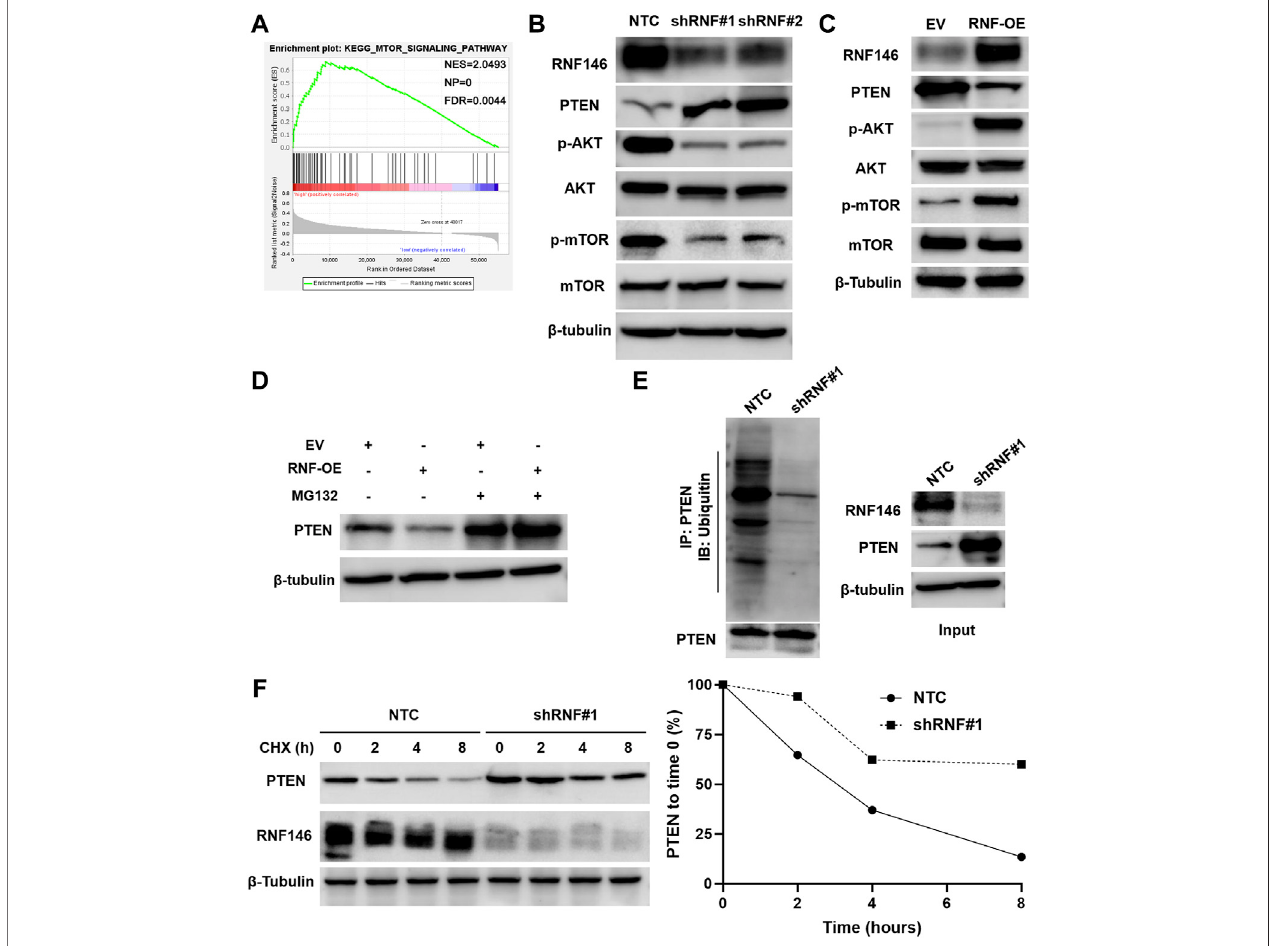
FIGURE6| RNF146regulatesthePTEN/AKT/mTORpathwayinHCCcells. (A) KEGGpathwayenrichmentanalysisindicatedaclosecorrelationbetweenRNF146 and the mTOR signaling pathway in HCC. (B) RNF146 knockdown increased PTEN expression but reduced p-AKT (Ser473) and p-mTOR (Ser2448) levels in HCCLM3 cells. (C) RNF146 overexpression decreased PTEN expression while increased p-AKT (Ser473) and p-mTOR (Ser2448) levels in Huh7 cells. (D) RNF146overexpression-induced PTENdownregulationwasblocked byaproteasome inhibitor MG132 inHuh7 cells. (E) TheubiquitinationofPTENwasreduced by RNF146 silencing in HCCLM3 cells. (F) The degradation of PTEN was reduced by RNF146 silencing in HCCLM3 cells.